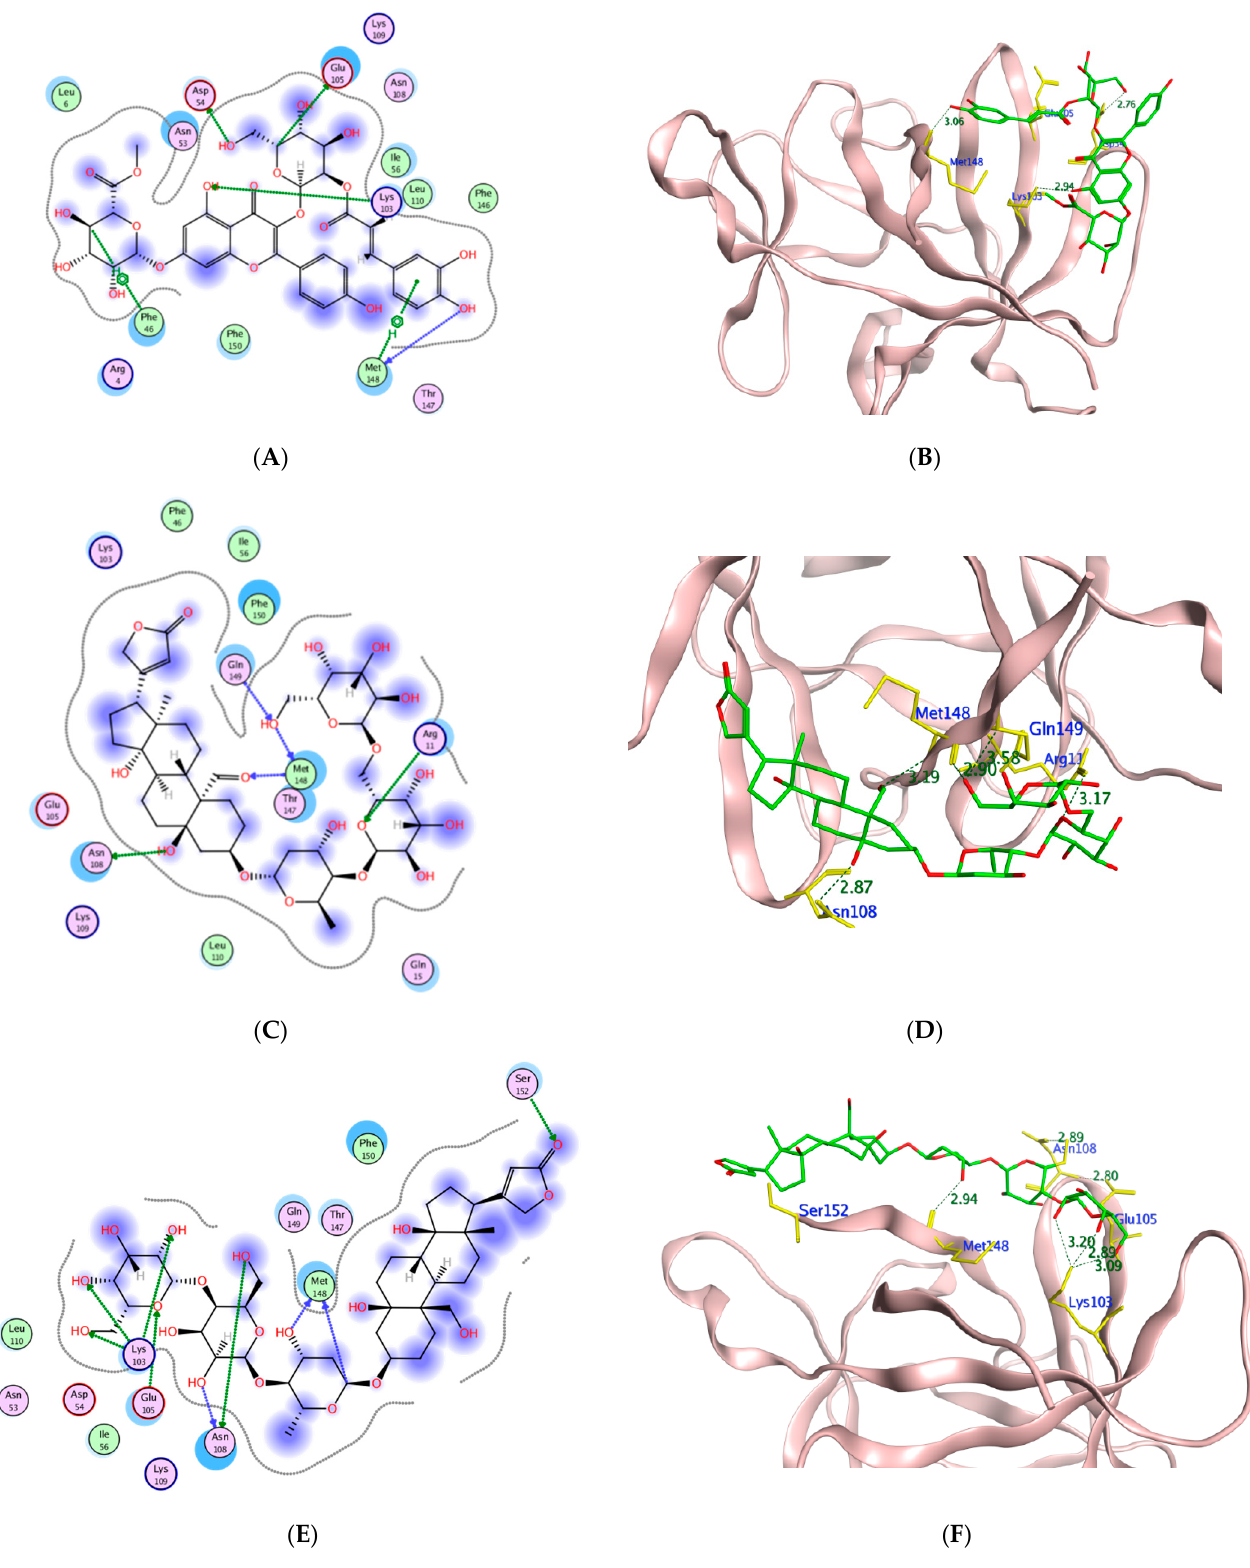
Figure 13. The 2D and 3D molecular docking presentation of the possible binding conformations of 19 ( A , B ), 20 ( C , D ), and 21 ( E , F ) in the IL-1 β binding site using PDB 6Y8M. The interacting residues are highlighted in the yellow stick model with H-bonds and H-pi interactions are presented as green and red dotted lines, respectively, having their distances illustrated in Å.